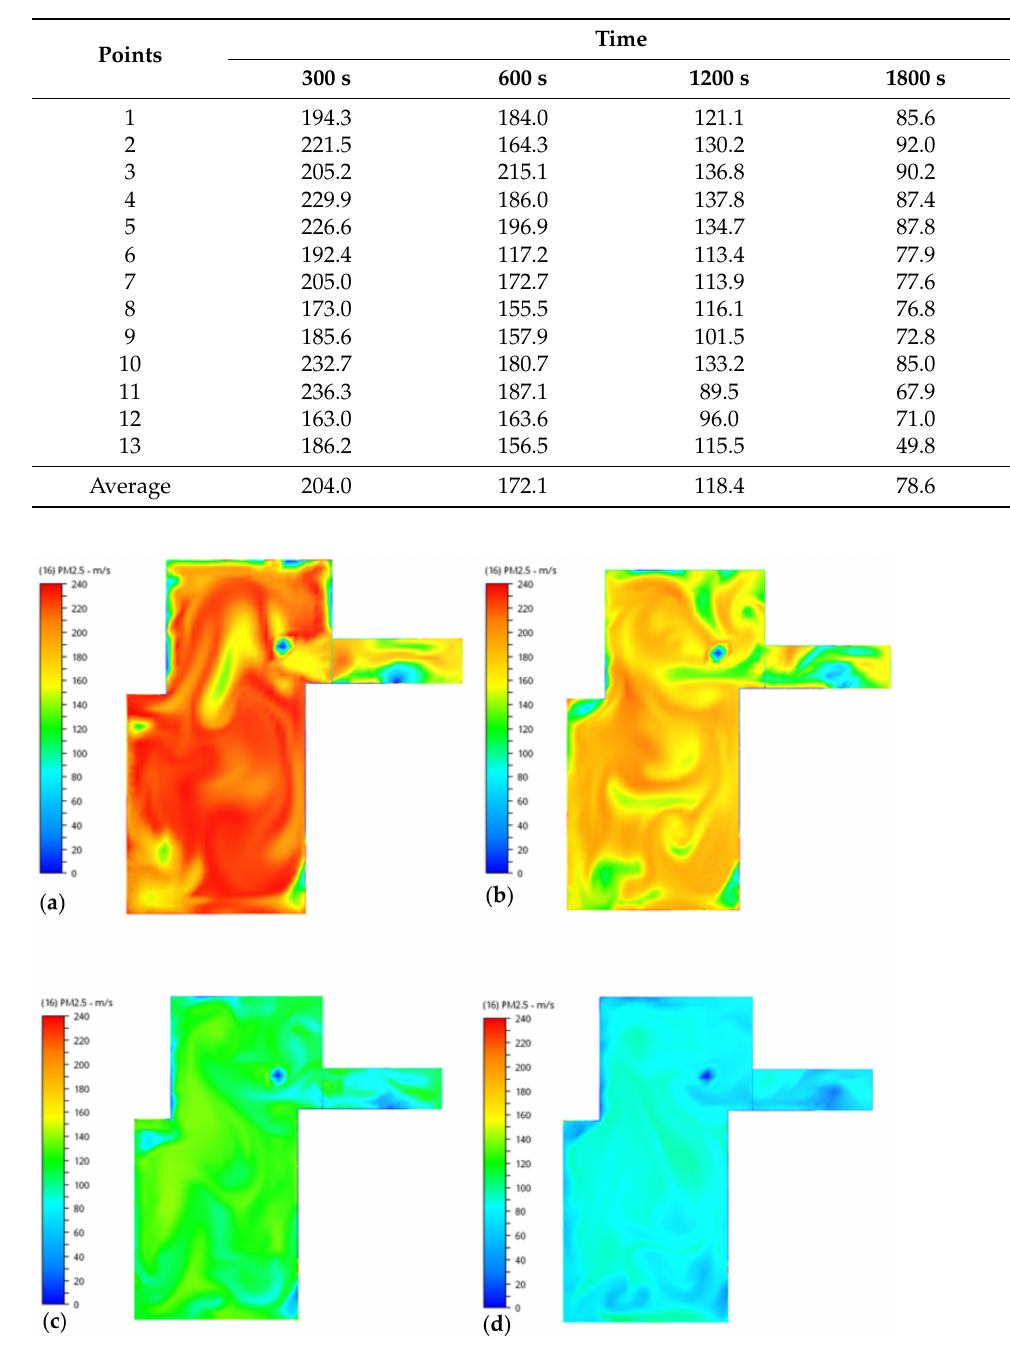
Figure 9. The simulation results of case 4 at the time of ( a ) 300 s; ( b ) 600 s; ( c ) 1200 s; ( d ) 1800